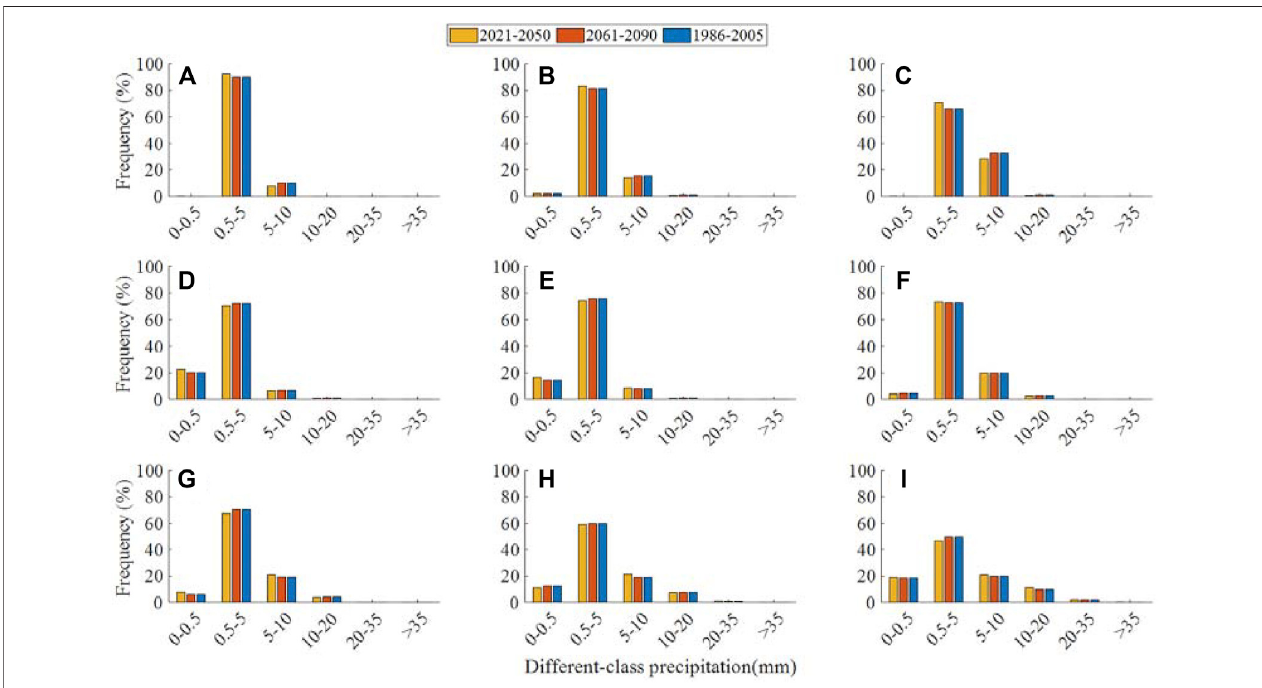
FIGURE 12 | Histogram of the frequency of the future projected precipitation in provinces [non-rainfall 0 – 0.5 mm day − 1 , very weak 0.5 – 5 mm day − 1 , relatively weak 5 – 10 mm day − 1 ,moderate10 – 20 mm day − 1 ,relatively heavy rainfall20 – 35 mm day − 1 , and veryheavy > 35 mm day − 1 . (A – I) representsnineregionsof (A) -Qinghai, (B) -Gansu,